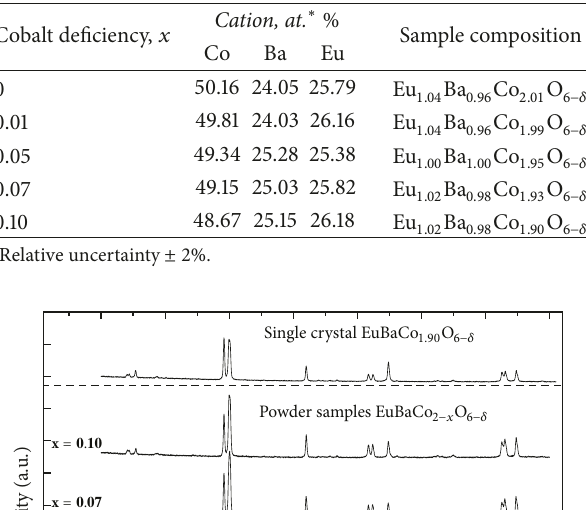
Table 1: The results of the elemental analysis of the as-prepared powder samples of EuBaCo 2−𝑥 O 6−𝛿 ( 𝑥 = 0–0.10).